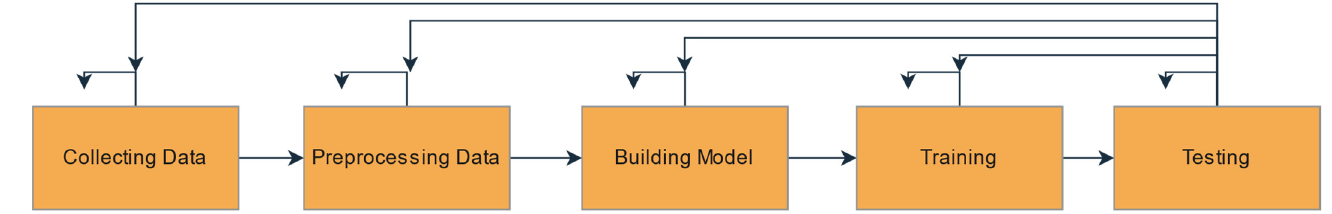
Figure 1. Modeling process with ML.